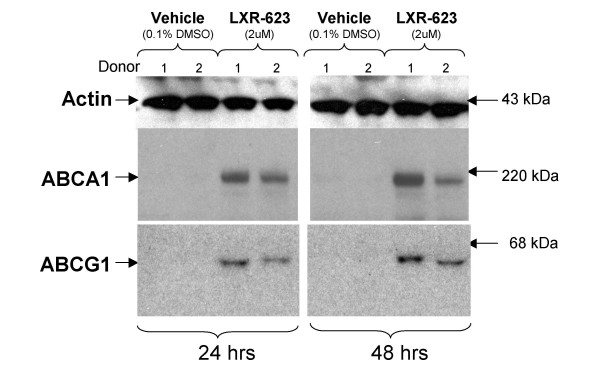
LXR-623 treatment of human PBMC ex vivo significantly increases protein levels of ABCA1 and ABCG1. Peripheral blood mononuclear cells (PBMC) were purified from normal human donors (n = 3), transferred to cell culture dishes, and treated with vehicle (0.1% DMSO) or LXR-623 (2 uM) for either 24 or 48 hours. Following incubation, cells were lysed and protein extracts were separated on SDS-PAGE and blotted with antisera raised to ABCA1, ABCG1, or actin (to serve as an indicator of protein loading per lane). Horseradish peroxidase-linked secondary antibodies were bound to the immobilized protein/antibody complexes, and proteins were visualized by chemiluminescence. Duplicate lanes for each treatment reflect the two different donors analyzed in this experiment. Molecular masses were estimated by the relative mobility of protein markers run in an adjacent lane on each gel.